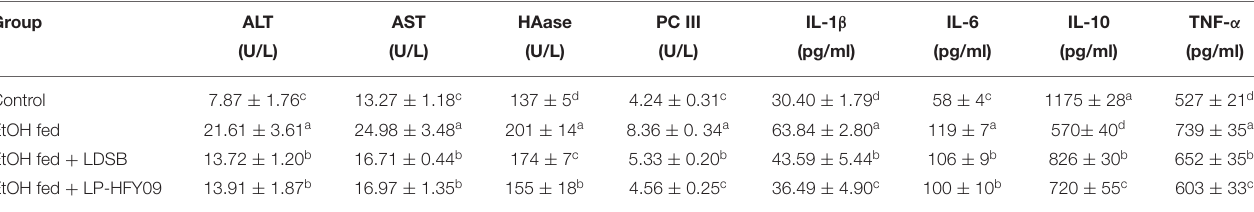
TABLE 2 | Serum levels of alanine aminotransferase (ALT), aspartic aminotransferase (AST), hyaluronidase (HAase), precollagen III (PC III), interleukin (IL)-1 β , IL-6, IL-10, and tumor necrosis factor- α (TNF- α ) of mice ( n = 10). Group ALT AST